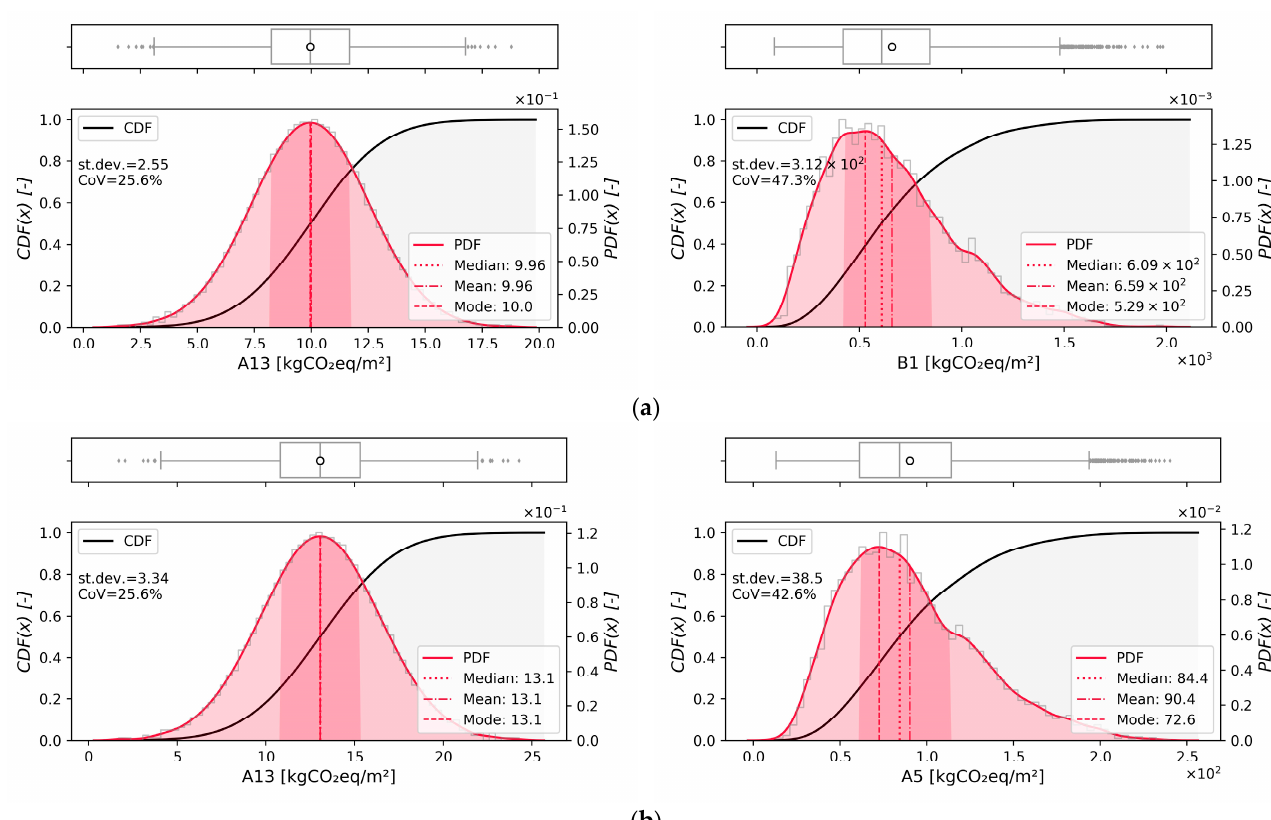
Figure 11. PDFs, CDFs, and box-whisker plots for the GWP due to heat production (B6) in: ( a ) the pre-retro fi t scenario; ( b ) the post-retro fi t scenario.